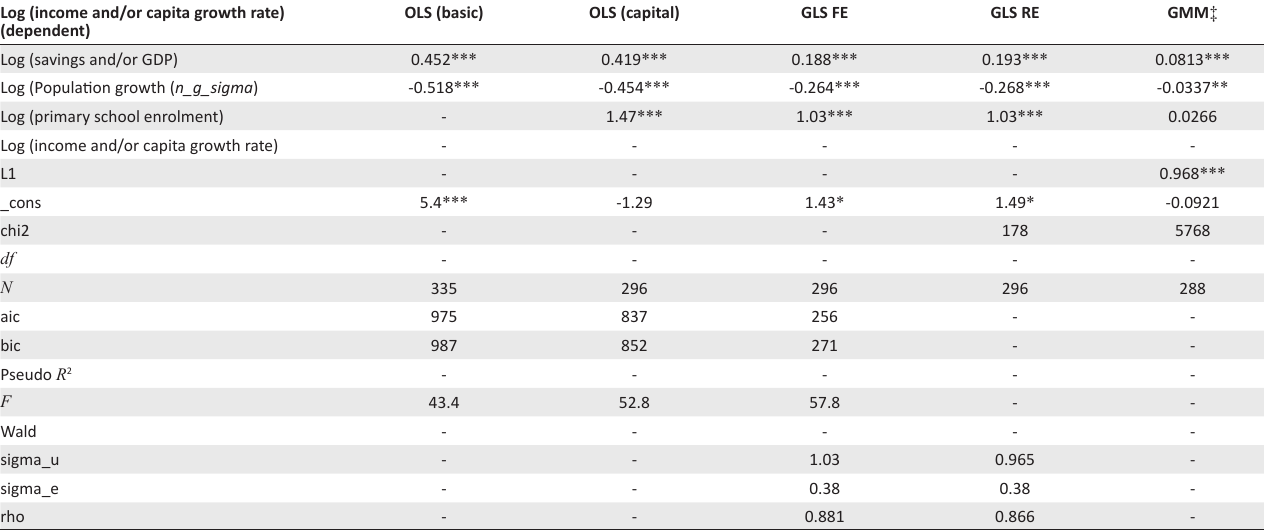
TABLE 5: Combined results from the all Solow models (ordinary least squares with Huber-White standard error) † Log (income and/or capita growth rate)